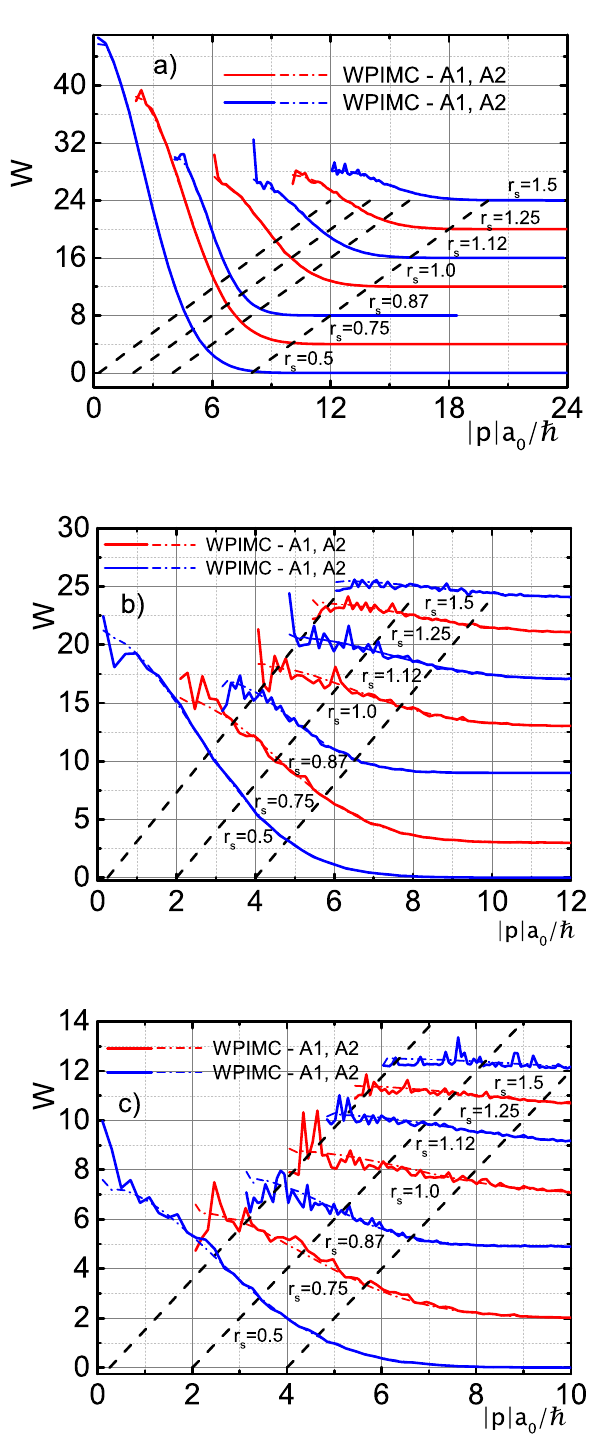
Figure 4. (Color online) The UEG electron momentum distribution functions W ( | p | a 0 /¯ h ) at Θ = 4—( a ), Θ = 2—( b ) and Θ = 1—( c ). Solid lines—WPIMC A1, dot-and-dash lines—WPIMC A2. For convenient representation all W ( | p | a 0 /¯ h ) for r s = 0.5 are divided by